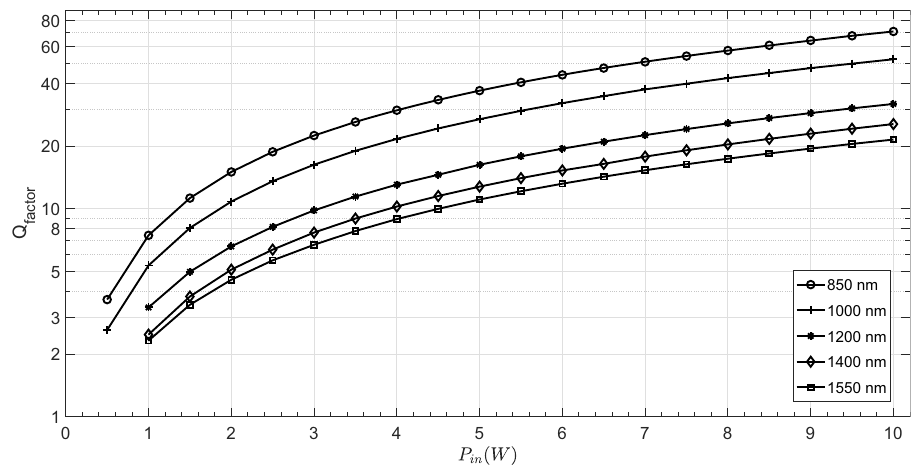
Figure 3: Quality factor ( Q factor ) as a function of the transmitted laser power ( P W in ( ) ) for a di ff erent laser wavelengths W/zero pointing